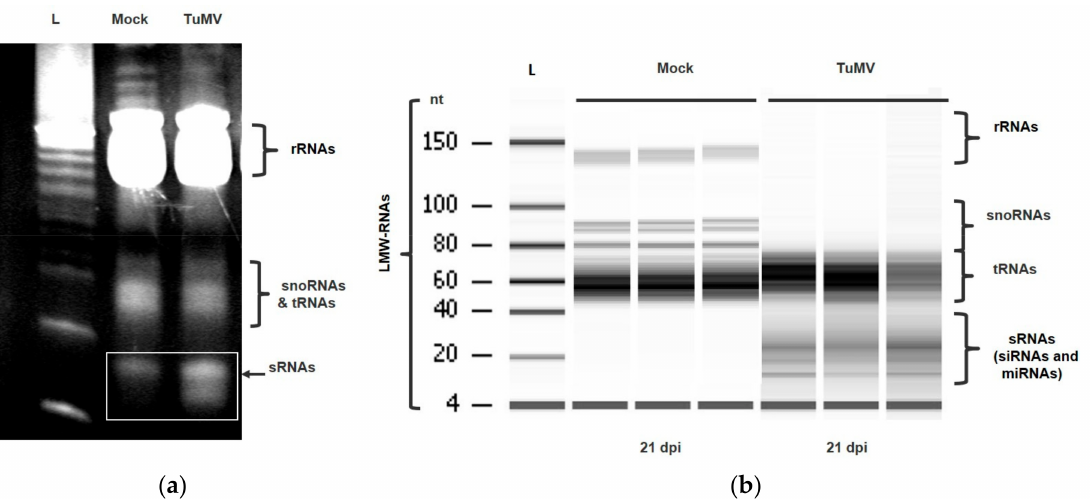
Figure 1. Example of ( a ) agarose gel photo of small RNAs in healthy vs. turnip mosaic virus (TuMV)- infected plant and ( b ) Agilent Bioanalyzer 2100 electrophoretic gel output with low molecular weight (LMW)-RNA components labelled. Three biological replicates of mock and TuMV-inoculated A. thaliana LMW-RNA at 21 days post inoculation (dpi). L, Ladder corresponding to 4 to 150 nu- cleotides (nt), 1, mock-inoculated plant LMW-RNA 1; 2, mock-inoculated plant LMW-RNA 2; 3, mock-inoculated plant LMW-RNA 3; 4, TuMV-inoculated plant LMW-RNA 1; 5, TuMV-inoculated plant LMW-RNA 2; 6, TuMV-inoculated plant LMW-RNA 3. Low molecular weight RNAs (LMW- RNAs), small RNAs (sRNAs; including microRNAs (miRNAs) and small interfering RNAs (siRNAs)), transfer RNAs (tRNAs), small nucleolar RNAs (snoRNAs) and ribosomal RNAs